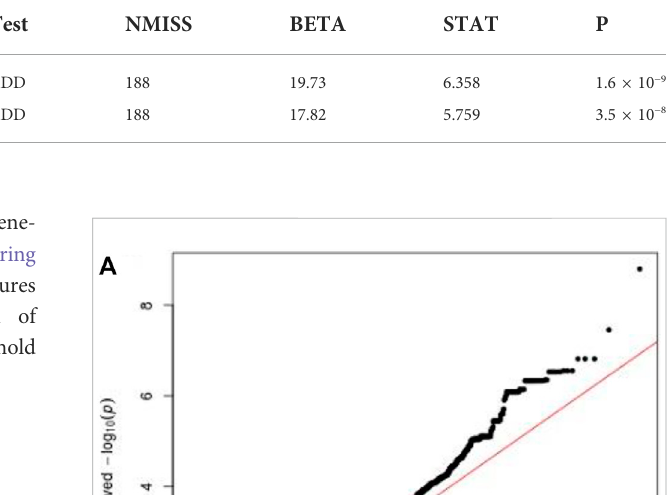
TABLE 2 Two lead single-variant associations detected in the GWAS analyses.